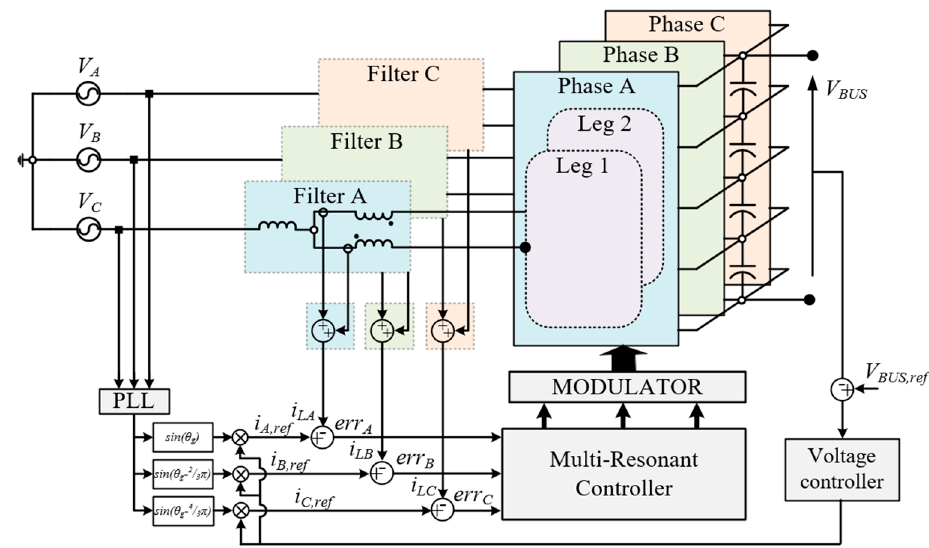
Figure 9. Block scheme of the 3 Φ 5L E-Type control algorithm for the grid-tied rectifier.